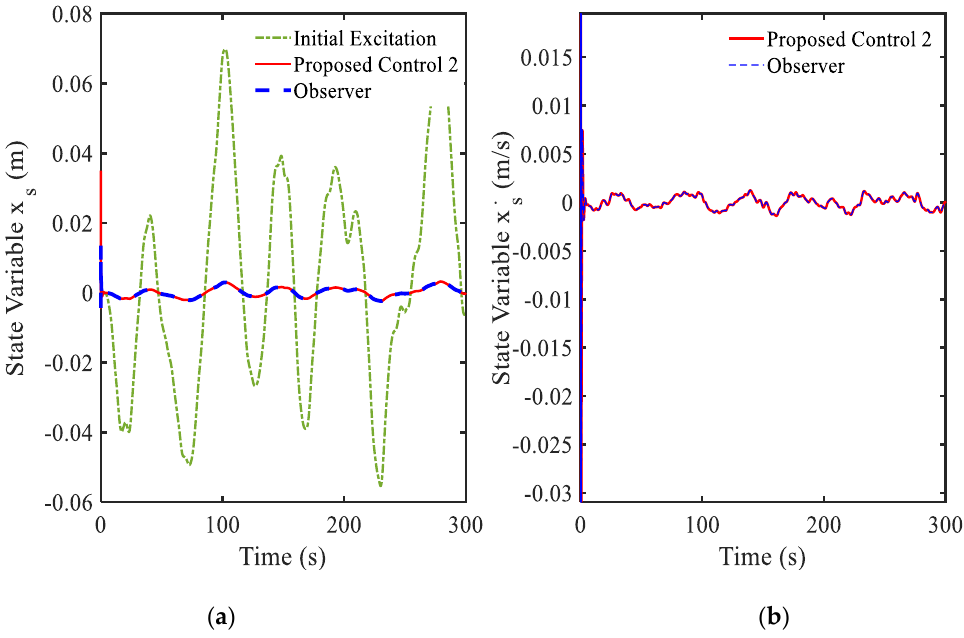
Figure 9. Vibration control results at the seat position under random bump road excitation: ( a ) displacement, ( b ) velocity.